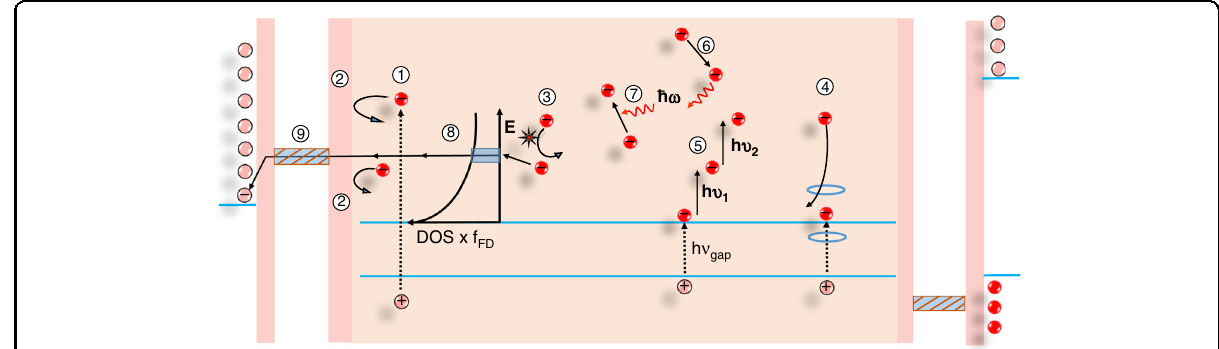
Fig. 5 The energy loss mechanisms of HC (hot electrons only), and their transfer to energy-selective contacts (ESCs). The numerical labels indicate each speci fi c process, namely (1) exciton generation, (2) hot electrons re fl ection at the ESC, (3) electron – electron collision, (4) impact ionization, (5) sub-bandgap photons reabsorbed by free electrons, (6) emission of optical phonon, (7) re-absorption of optical phonon, (8) quasi- ballistic transport of HC, (9) tunneling of HC from the photoabsorber to the interfacial contact. The fi gure is taken with permission from ref.